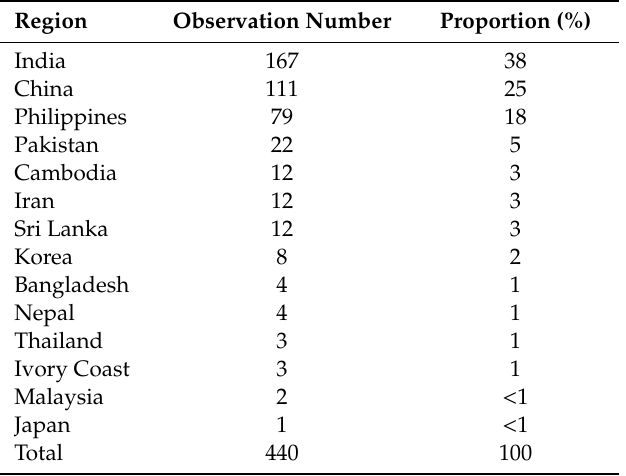
Table 1. Locations and observation number of the studies included in the meta-analysis. Region Observation Number Proportion